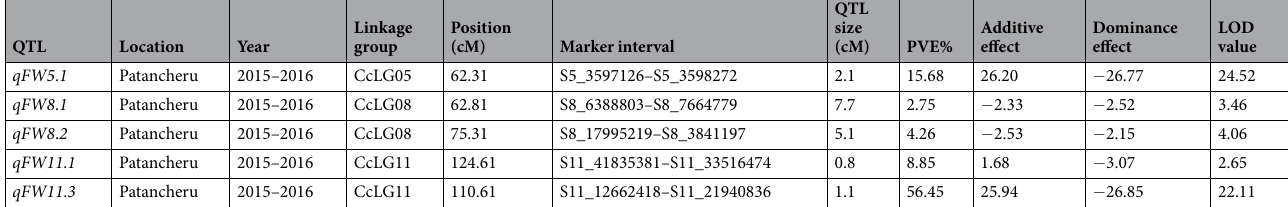
Table 5. Summary on QTL mapping for FW resistance on the genetic map derived from F 2 (ICPL 85063 × ICPL 87119) population.